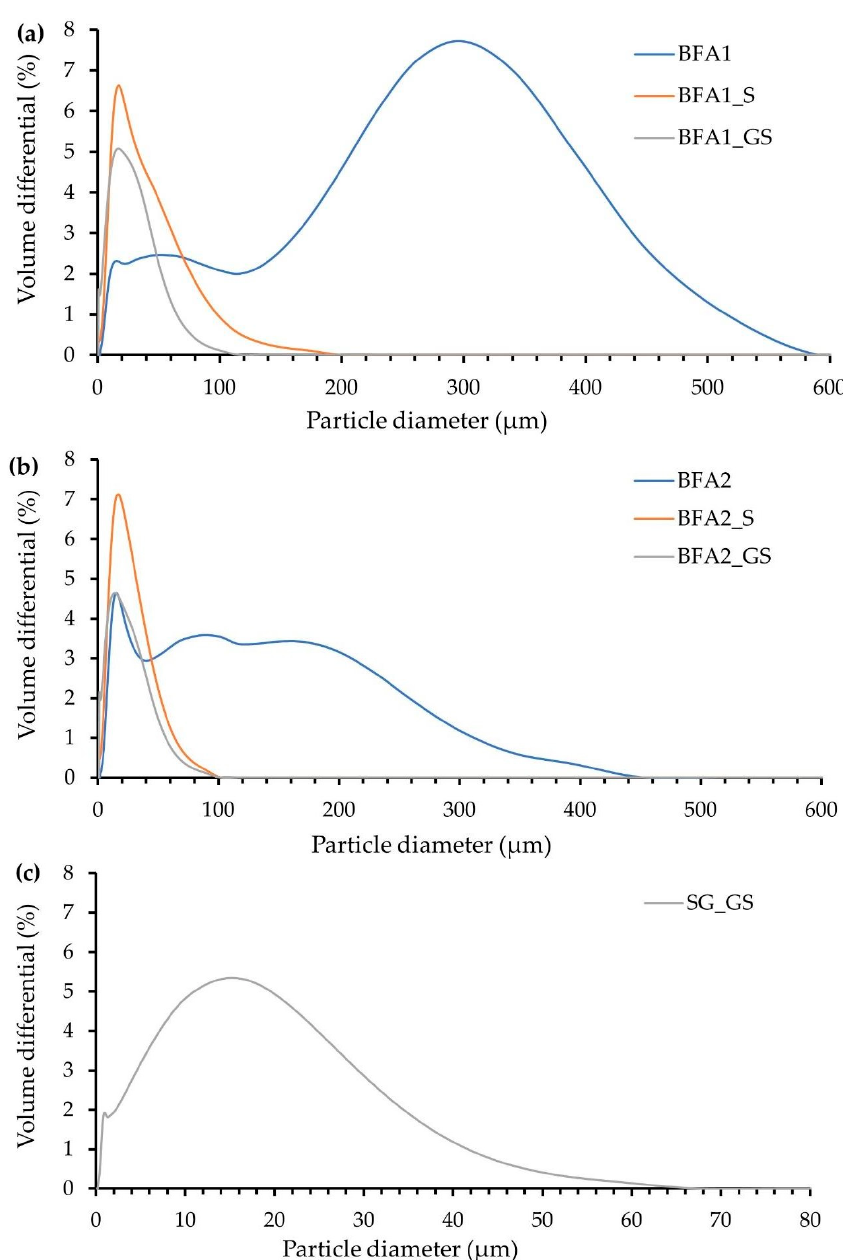
Figure 2. Particle size distribution of the waste samples: ( a ) BFA1, as received and pre-treated; ( b ) BFA2, as received and pre-treated; ( c ) pre-treated